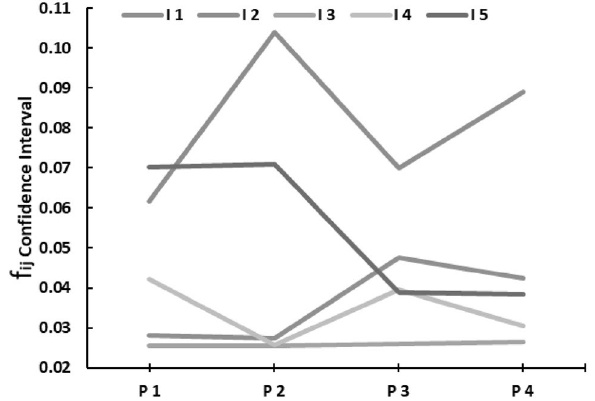
Fig. 17 95% confidence intervals on interwell connectivities ( f mated by D-CRMP in homogeneous case III. Subscript i and j stand for injector and producer index in range 1–5 and 1–4, respectively